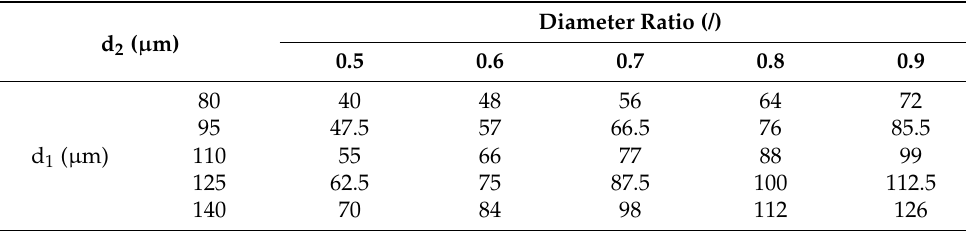
Table 1. Full factorial design of experiment plan to investigate the influence of particle diameter and diameter